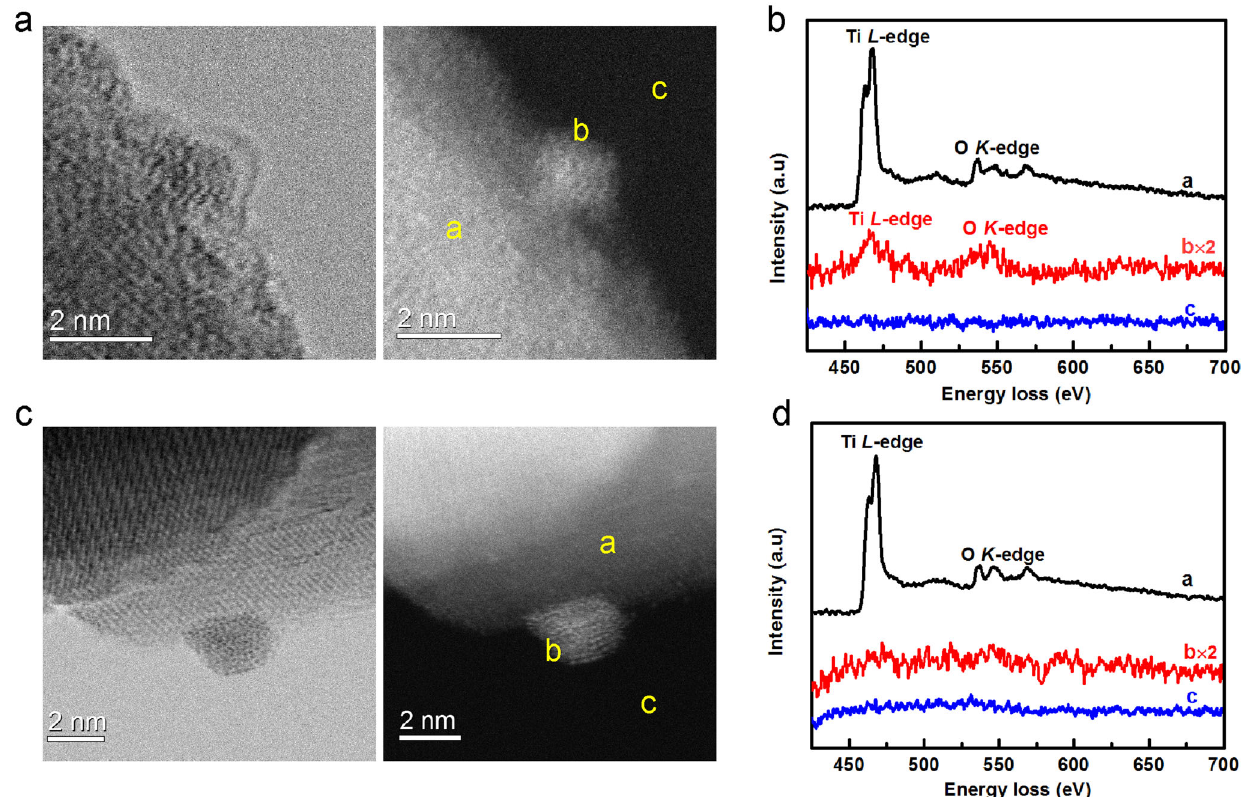
Fig. 2 Structural characterization of Pd/TiO 2 serial catalysts. a BF-STEM and HAADF-STEM images of Pd/TiO 2 -600H. b EELS spectra of Pd/TiO 2 -600H. c BF-STEM and HAADF-STEM images of Pd/TiO 2 -600H-O300. d EELS spectra of Pd/TiO 2